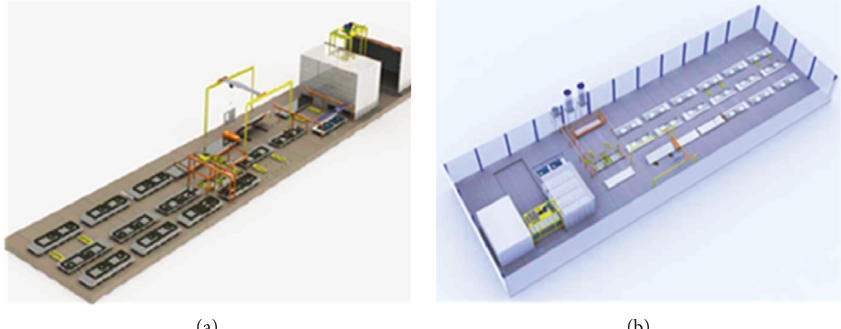
Figure 2: The production line of prefabricated components. (a) multifunctional mixed production line and (b) specific component production